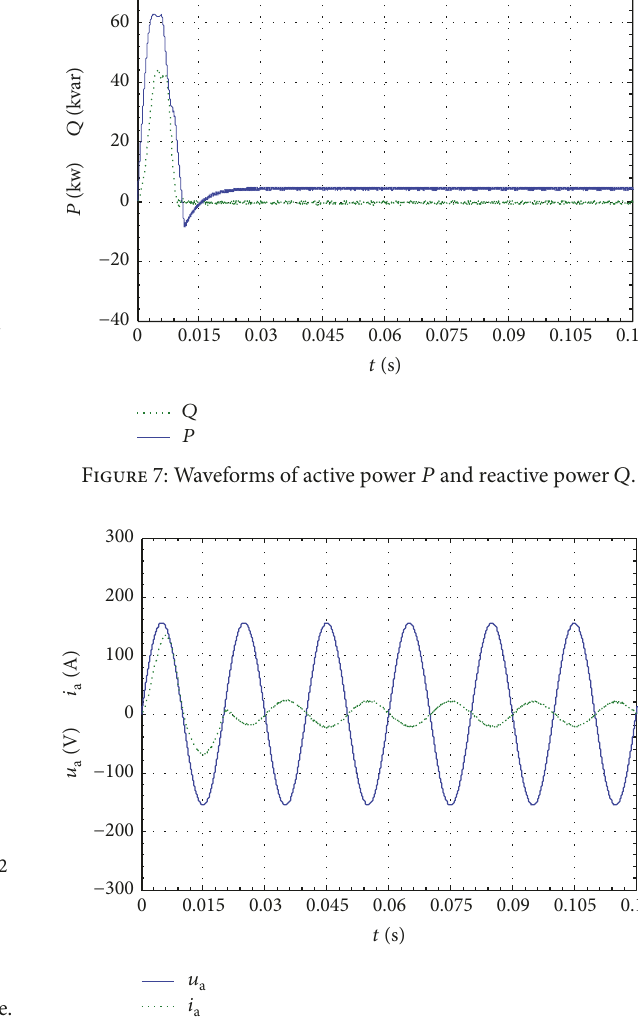
Figure 8: 𝐴 -phase voltage and current waveforms in inverter